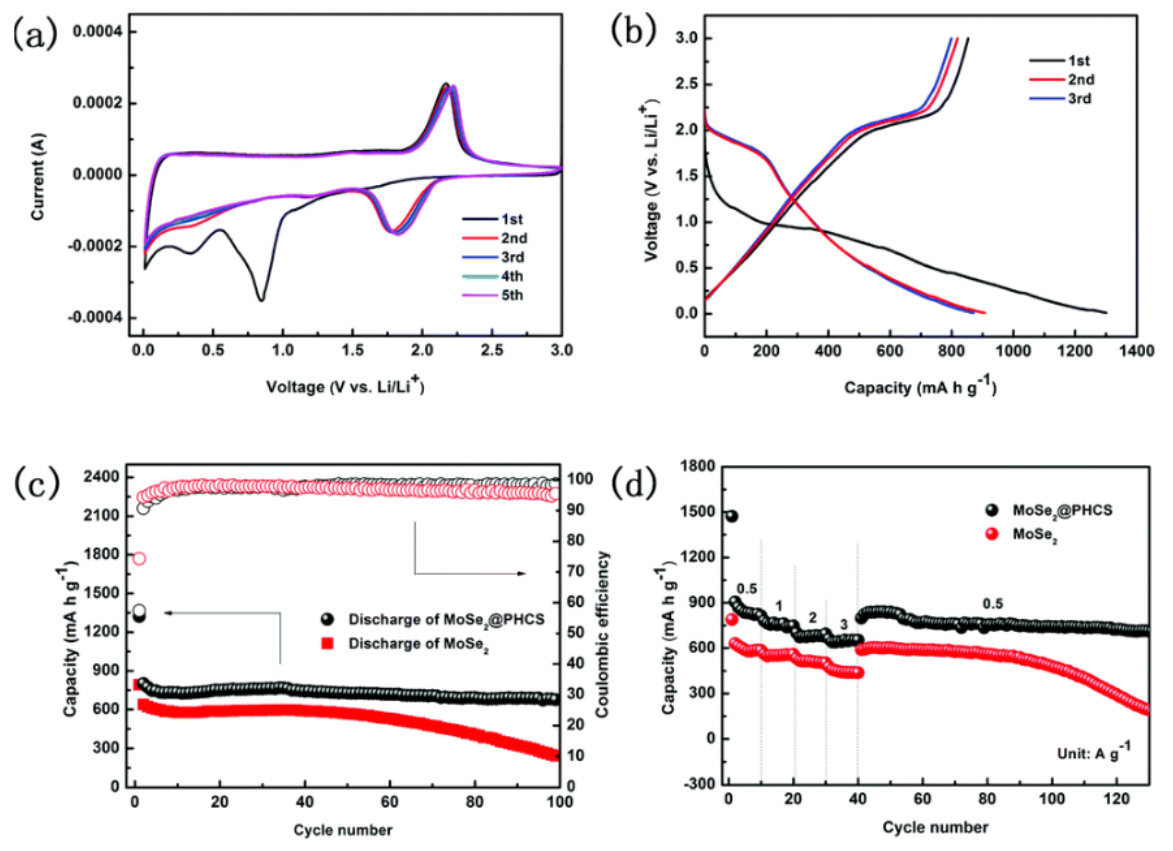
Figure 11. Electrochemical performance of the MoSe 2 @ PHCS composite and MoSe 2 nanosheets for lithium batteries (the capacities were calculated based on MoSe 2 mass). ( a ) Cyclic voltammogram profiles of the MoSe 2 @PHCS composite at a scan rate of 0.2 mV s − 1 . ( b ) Discharge/charge voltage profiles of the MoSe 2 @PHCS composite. ( c ) Cycling performance and Coulombic efficiency of the MoSe 2 @PHCS composite and MoSe 2 nanosheets within a voltage range of 0.01–3.0 V. ( d ) The capacity of the MoSe 2 @PHCS composite and MoSe 2 nanosheets under different current densities between 0.01 and 3.0 V. Reproduced with permission of ref. [129]. Copyright 2015. Royal Society of